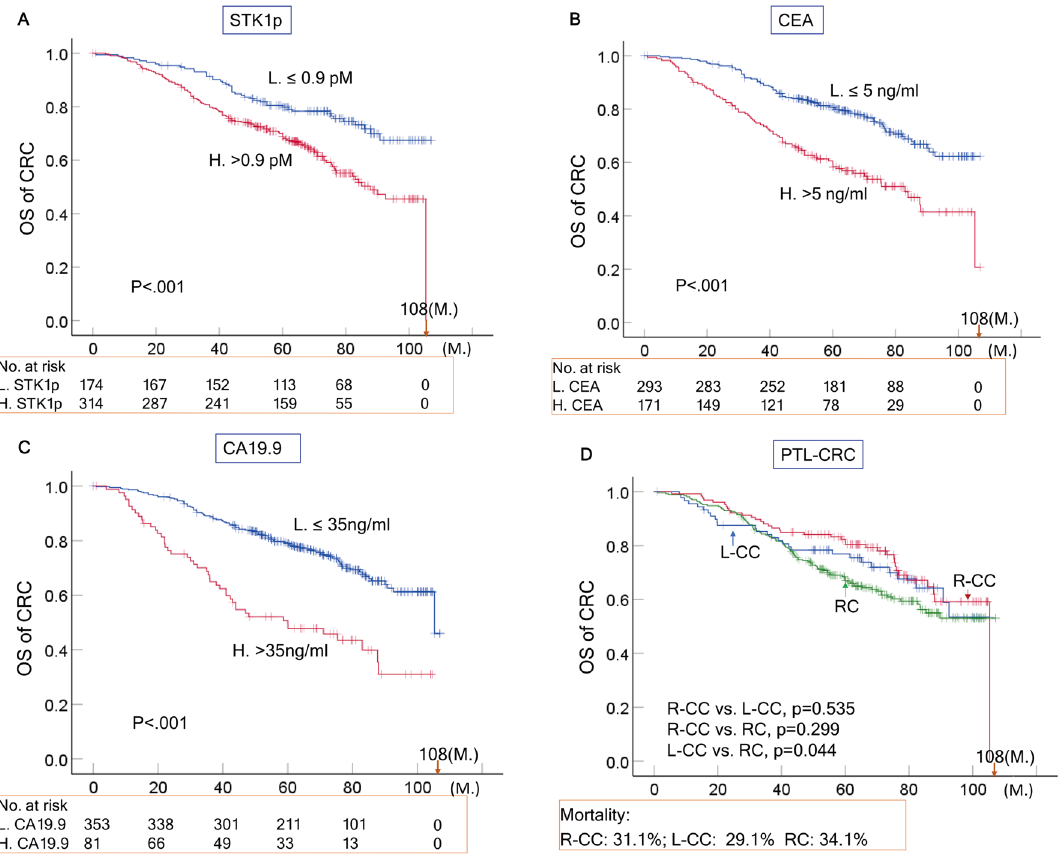
Fig. 2 Overall survival (OS) rate of CRC patients related to STKIp, CEA and CA19.9 ( A – C ) and the OS rate related to PTL of CRC ( D ) based on the Kaplan–Meier plotter database. The solid dots in the survival curves show the times of censored observations. M: